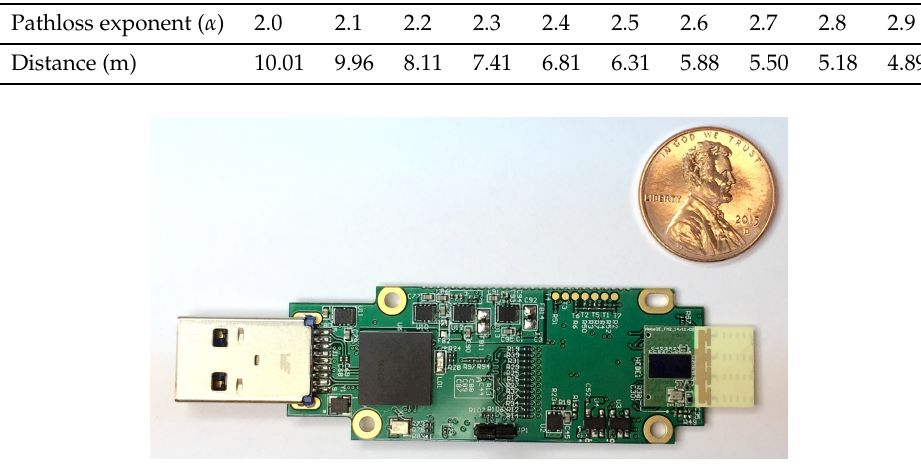
Figure 3. Tensorcom 802.11ad module for evaluation kit.